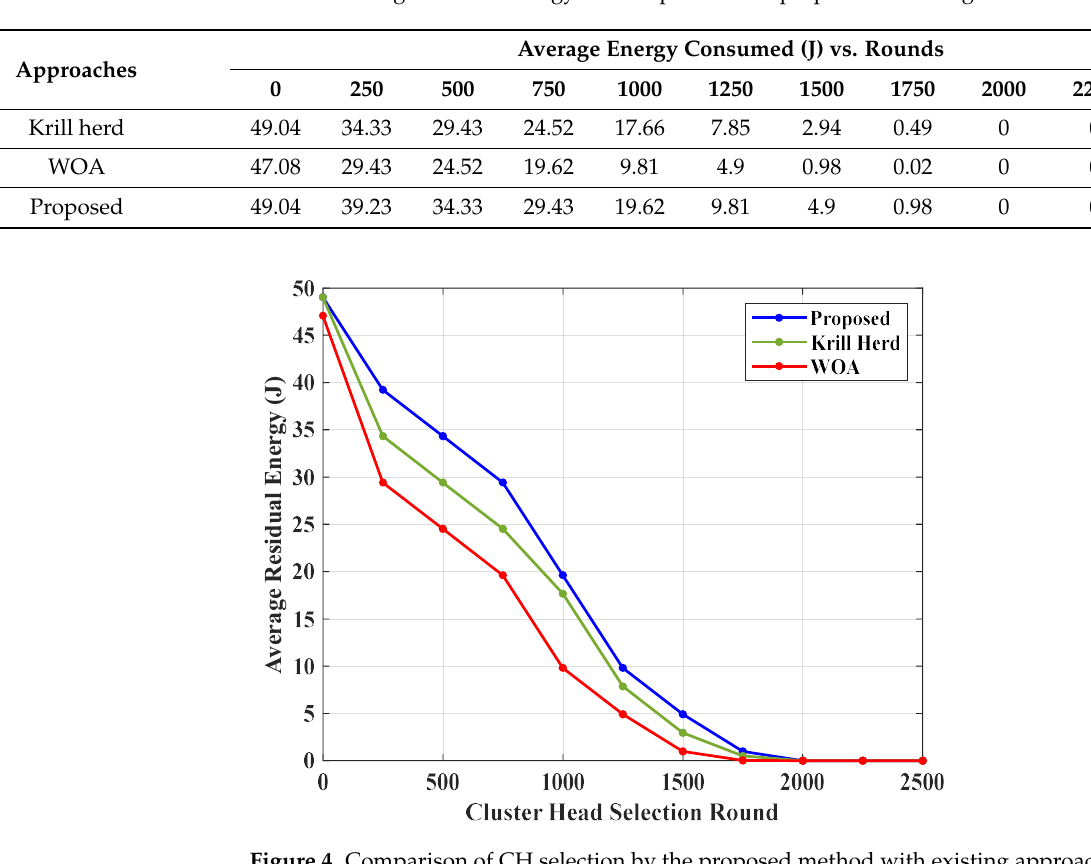
Figure 5. Energy consumption comparison.